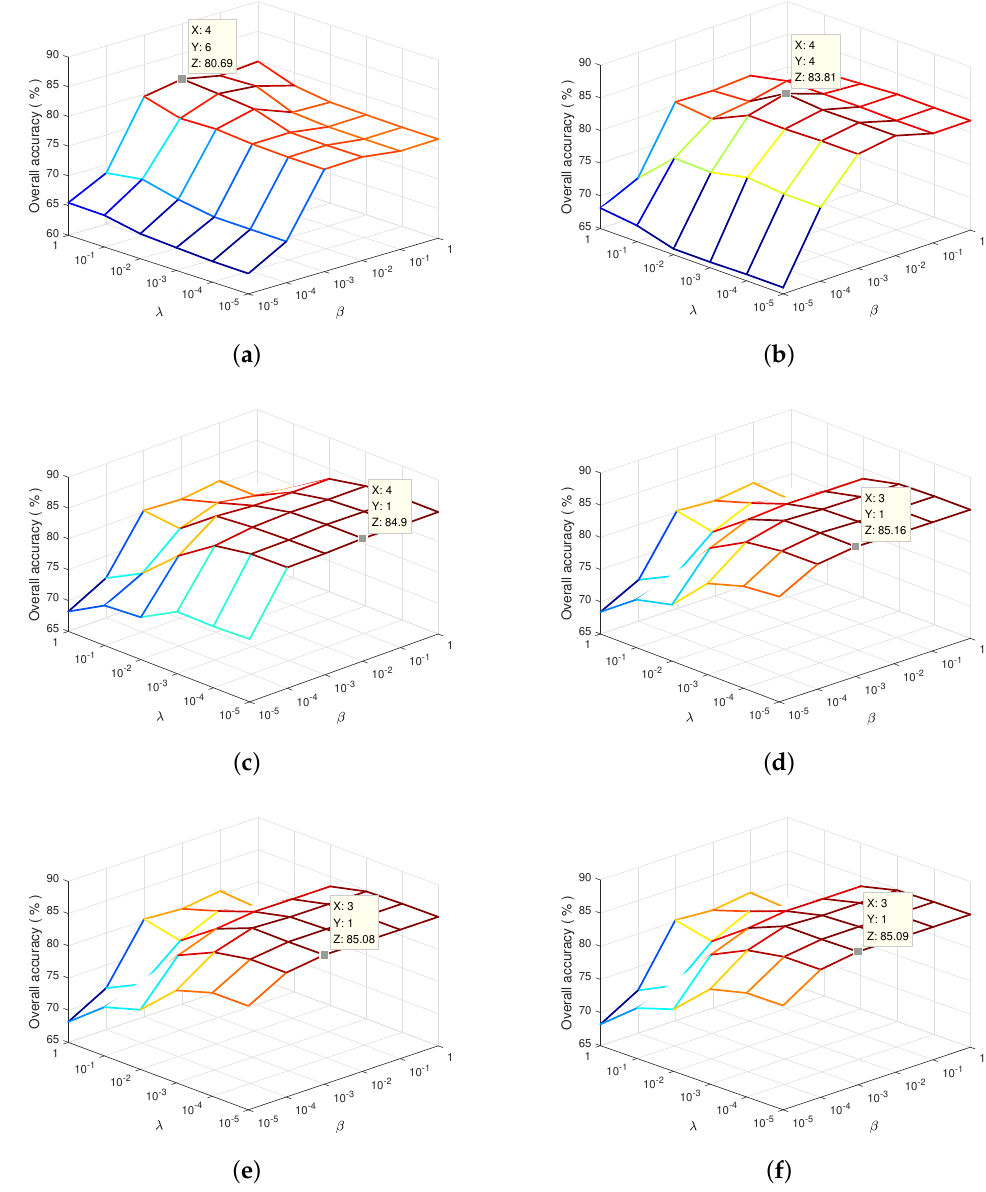
Figure 3. Parameter analysis of β , λ with different γ for the Pavia University data: ( a ) γ = 1, ( b ) γ = 0.1, ( c ) γ = 0.01, ( d ) γ = 0.001, ( e ) γ = 0.0001, ( f ) γ =